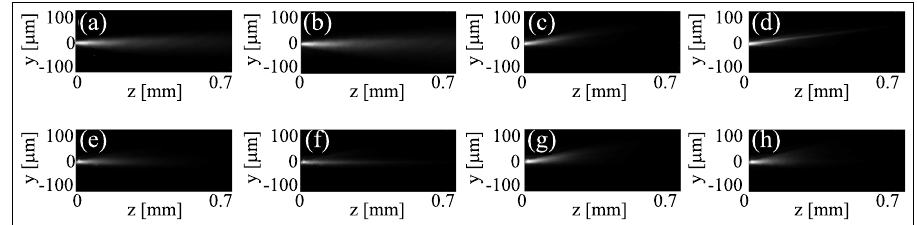
Figure 6. Acquired images of beam evolution at two wavelengths: top, λ i = 1064 nm, bottom, λ g = 532 nm. ( a , b ) The near-infrared beam diffracts when polarized as an ordinary wave, irrespective of the power; ( c , d ) when extraordinarily polarized, the beam goes from diffraction at low power ( P < 1mW) in ( c ) to self-confinement for P = 4 mW in ( d ). ( e , f ) The green beam (within the absorption band of the DDNLC) in the ordinary polarization undergoes self-focusing when increasing power from P g = 1 mW ( e ) to P g = 6 mW ( f ); ( g , h ) when polarized as an extraordinary wave it